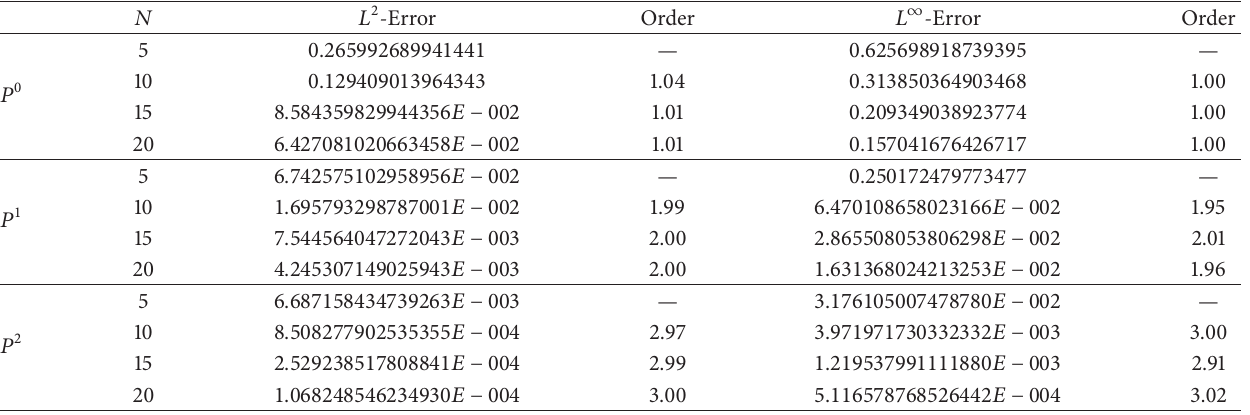
Table 2: Spatial accuracy test for the fractional order equation with the forcing term (42). 𝛼 = 0.2 , 𝑀 = 10 4 , 𝑇 = 1 . 𝑁 𝐿 2 -Error Order 𝐿 ∞ -Error Order 𝑃 0